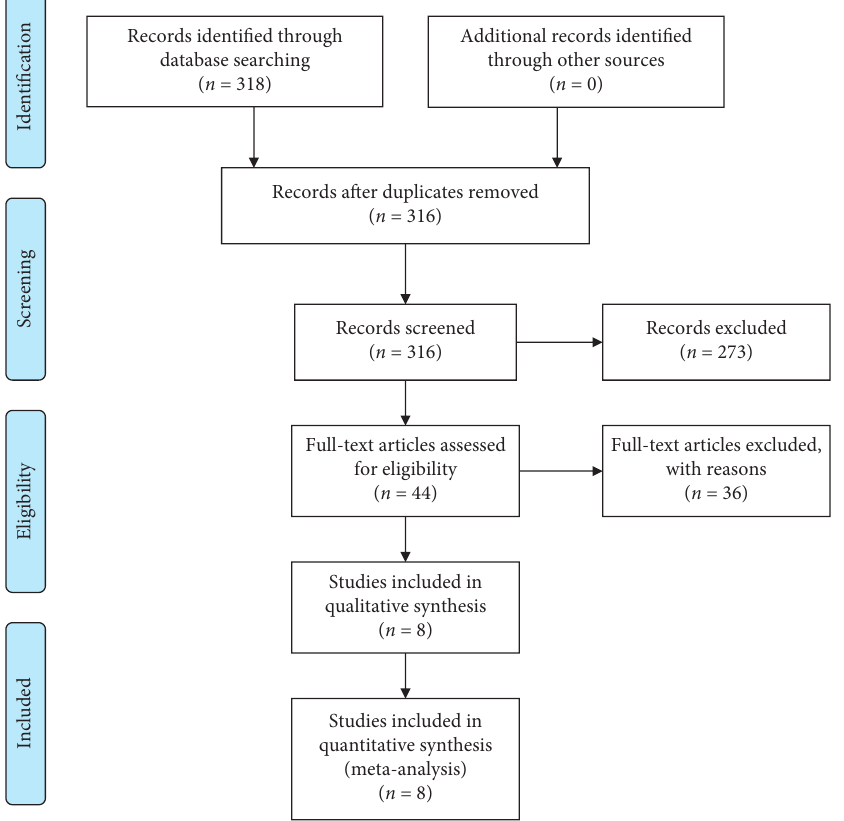
Figure 1: Inclusion and exclusion